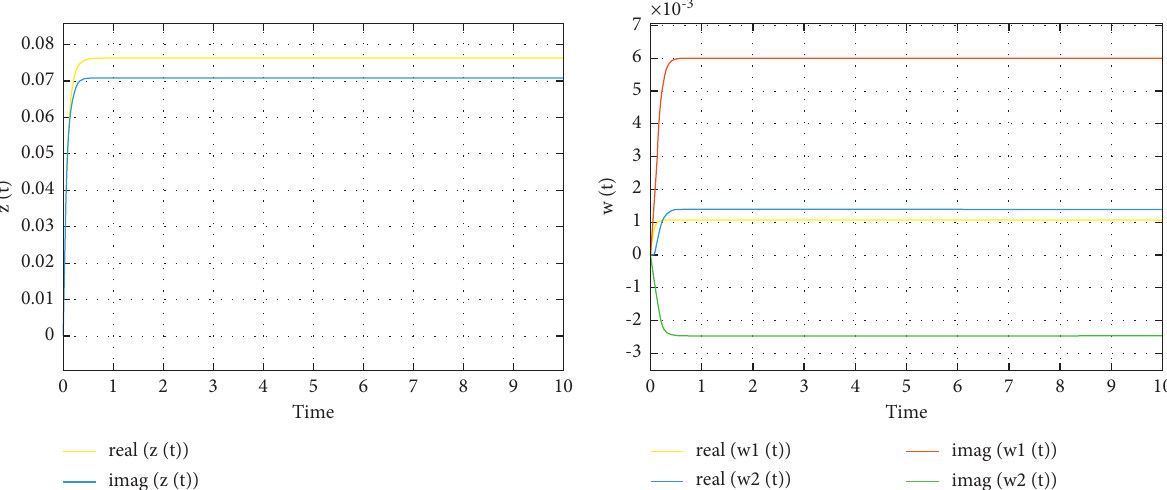
Figure 2: Curves of the real and imaginary parts of z ( t ) and w ( t ) in Example